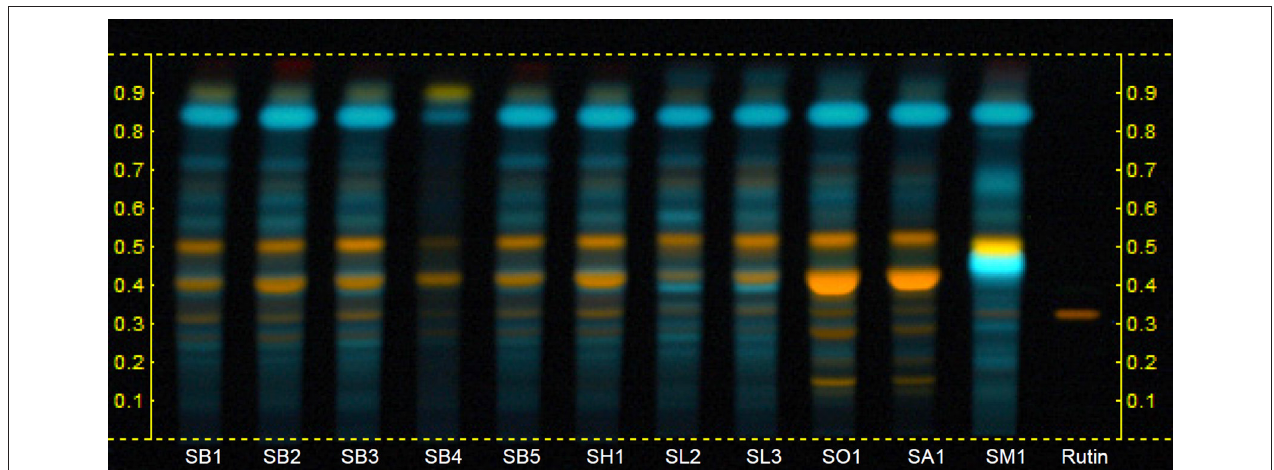
FIGURE 2 | HPTLC fingerprints of hydroalcoholic extracts of the aerial parts of Salvia species used in Valencian folk medicine. Mobile phase : Ethyl acetate:formic acid:acetic acid:water (100:10:10:25). Derivatization: NPR + PEG 400, UV 366 nm. Track identification: SB1 to SB5, S. blancoana subsp. mariolensis ; SH1, S. x hegelmaieri ; SL2 and SL3, S. officinalis subsp. lavandulifolia ; SO1, S. officinalis subsp. officinalis ; SA1, S. x auriculata ; SM1, S. microphylla var. microphylla